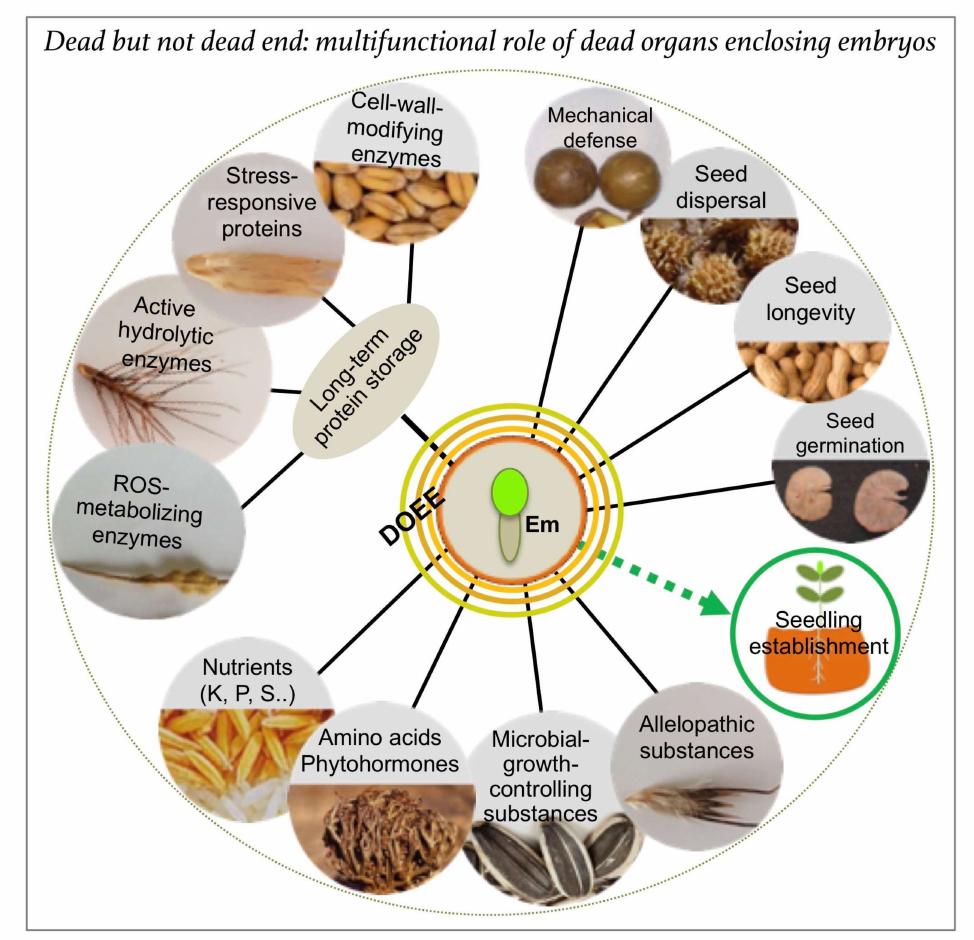
Figure 2. Dead organs enclosing the embryo (DOEEs) represent multifunctional structures that provide mechanical defense and accessories for dispersal together with a rich storage for nutrients, proteins, and other regulatory substances. The embryo (Em) can be covered with one to four dead layers (colored circles) that act together to ensure o ff spring success in the habitat providing multiple beneficial proteins whose activities can persist for decades within the dead organs. Other substances, including microbial growth and allelopathic substances, nutrients, amino acids and phytohormones, may control longevity, growth, and development to bring about seedling vigor and